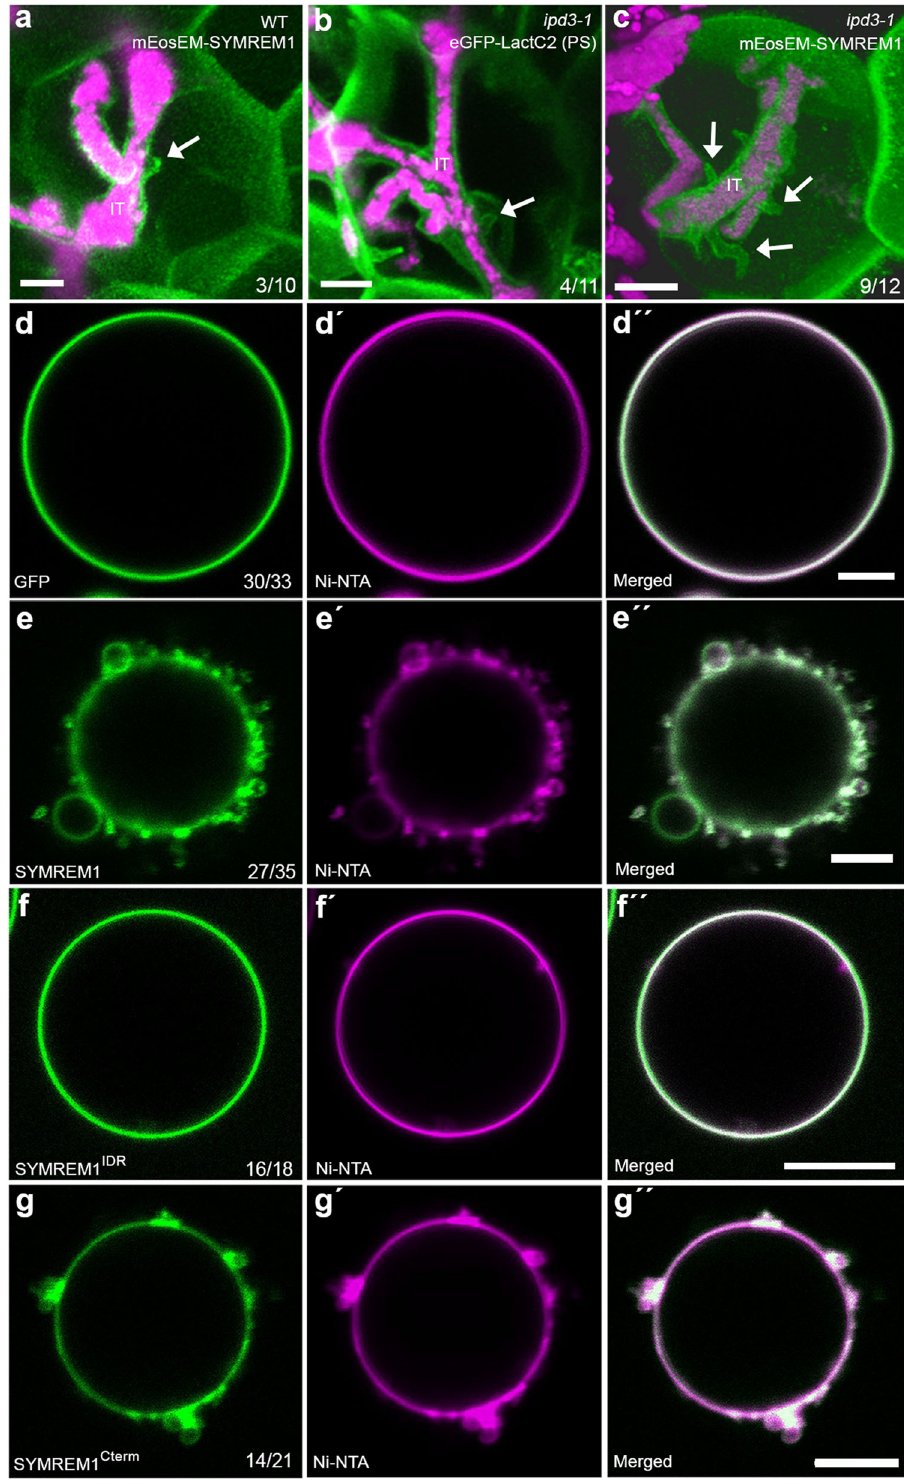
Fig. 3 | SYMREM1 can induce membrane morphology changes. a – c Membrane tubes were found on nodular ITs in the ipd3-1 mutant (arrow, b ), while ectopic expression of SYMREM1 greatly increased these tubular outgrowths in the ipd3-1 mutant (arrows, c ) but not on WT (arrow, a ). Membranes were visualized by expressing mEosEM-SYMREM1 ( a , c ) or the phosphatidylserine (PS) biosensor LactC2 ( b ), both shown in green. IT infection thread. S. meliloti expressing a mCherry marker is shown in magenta. Data were collected based on three biolo- gical replicates. All images were taken as z-stacks (internal distance is 0.5 μ m) and